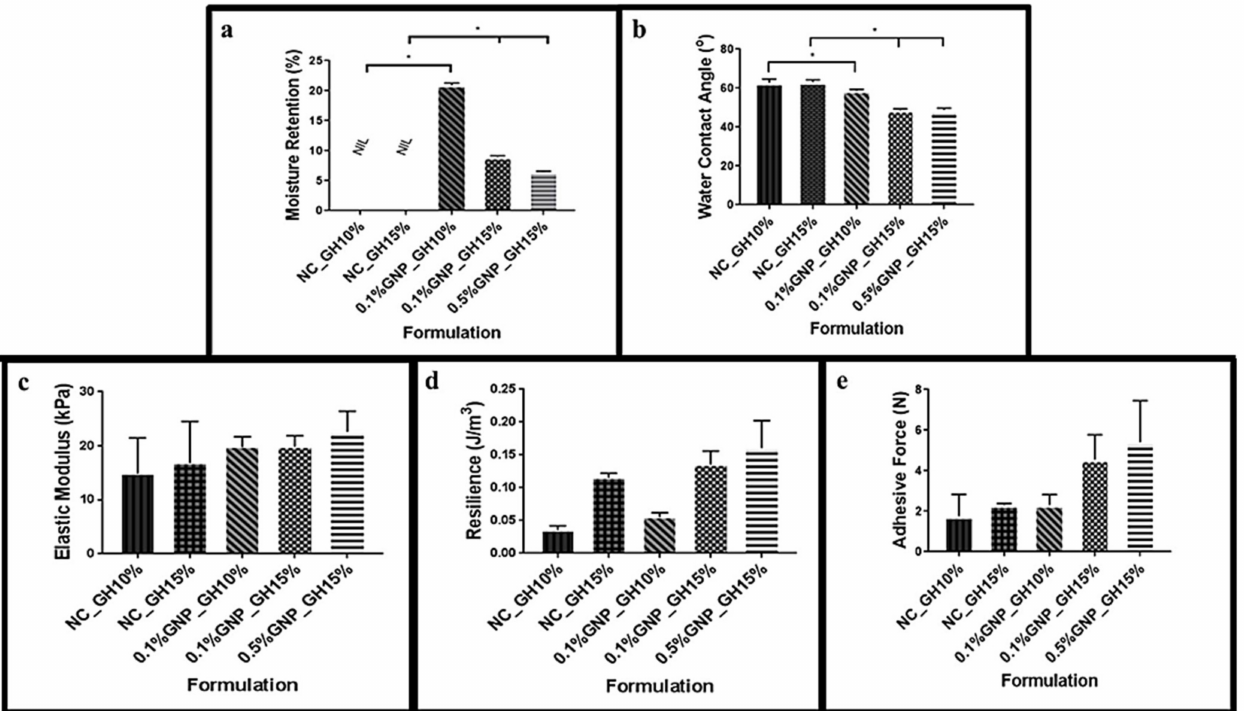
Figure 4. Retention, wettability and mechanical properties. ( a ) GNP_GH was able to conserve moisture and significantly different from NC_GH groups, which were unstable in liquid environments. ( b ) GNP_GH groups were assigned as hydrophilic scaffolds (wettability < 90 ◦ ) and significantly more hydrophilic than NC_GH groups. ( c ) GNP crosslinking enhanced the elasticity of GH. ( d ) and ( e ) GNP_GH groups were slightly more resilient and adhesive than NC_GH groups. * represented significant difference ( p < 0.05, n = 3, N =